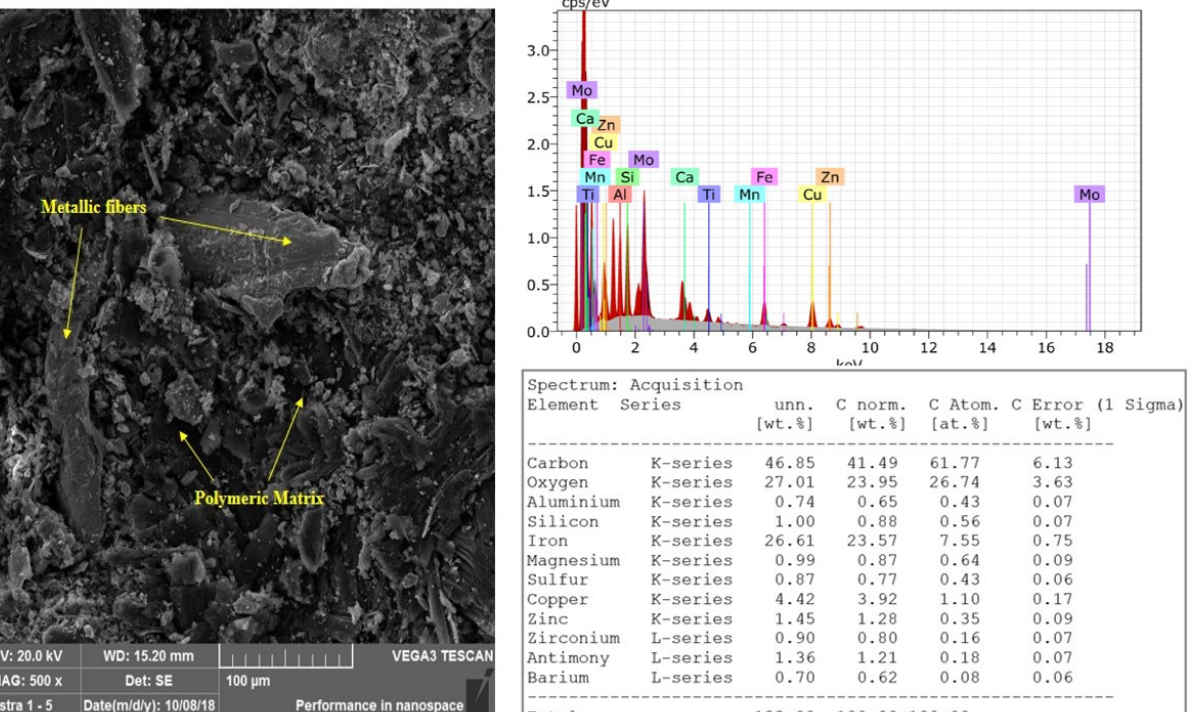
Figure 4. Coefficient of friction and temperature vs. number of brakes— Δ V = 40 Km/h.